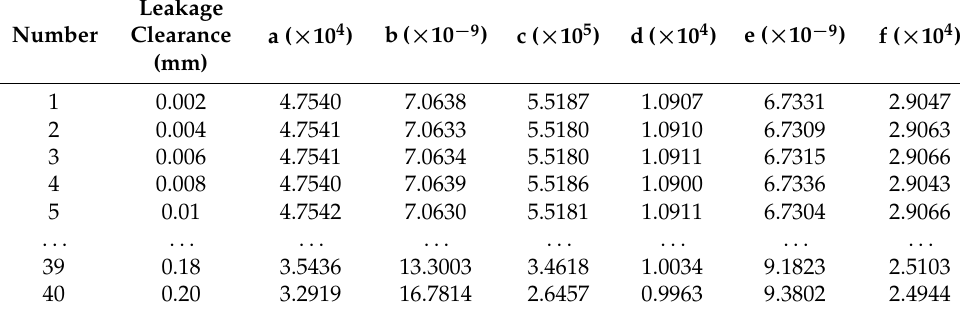
Table 10. Partial data of reversing valve leakage training set.